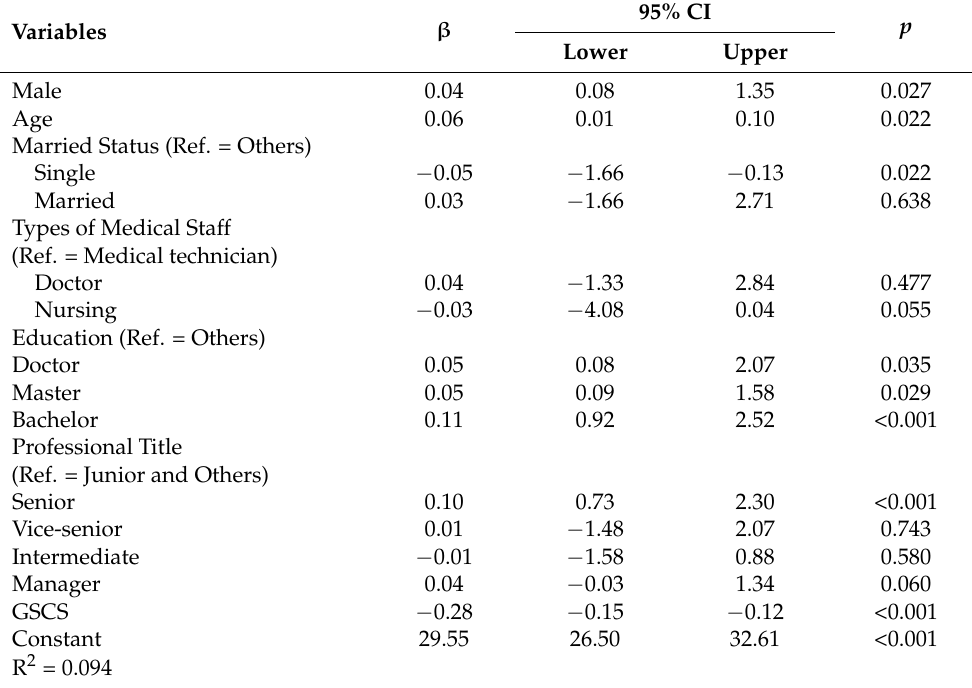
Table 5. OLS regression for the effect of general social capital on psychological